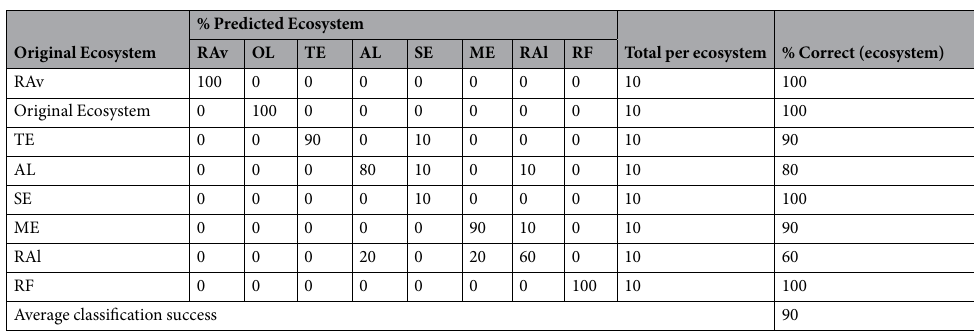
Table 2. Classification success (by ecosystem) of a linear discriminant analysis (LDA) for Cerastoderma edule shells based on trace element fingerprints. Ria de Aveiro (RAv), Óbidos lagoon (OL), Tagus estuary (TE), Albufeira lagoon (AL), Sado estuary (SE), Mira estuary (ME), Ria de Alvor (RAl) and Ria Formosa (RF). .